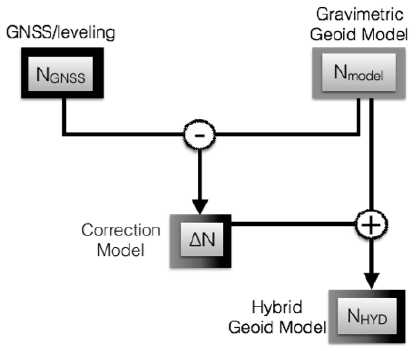
Figure 2 - Methodology of Hybrid Geoid Models (see the colors in the online version).